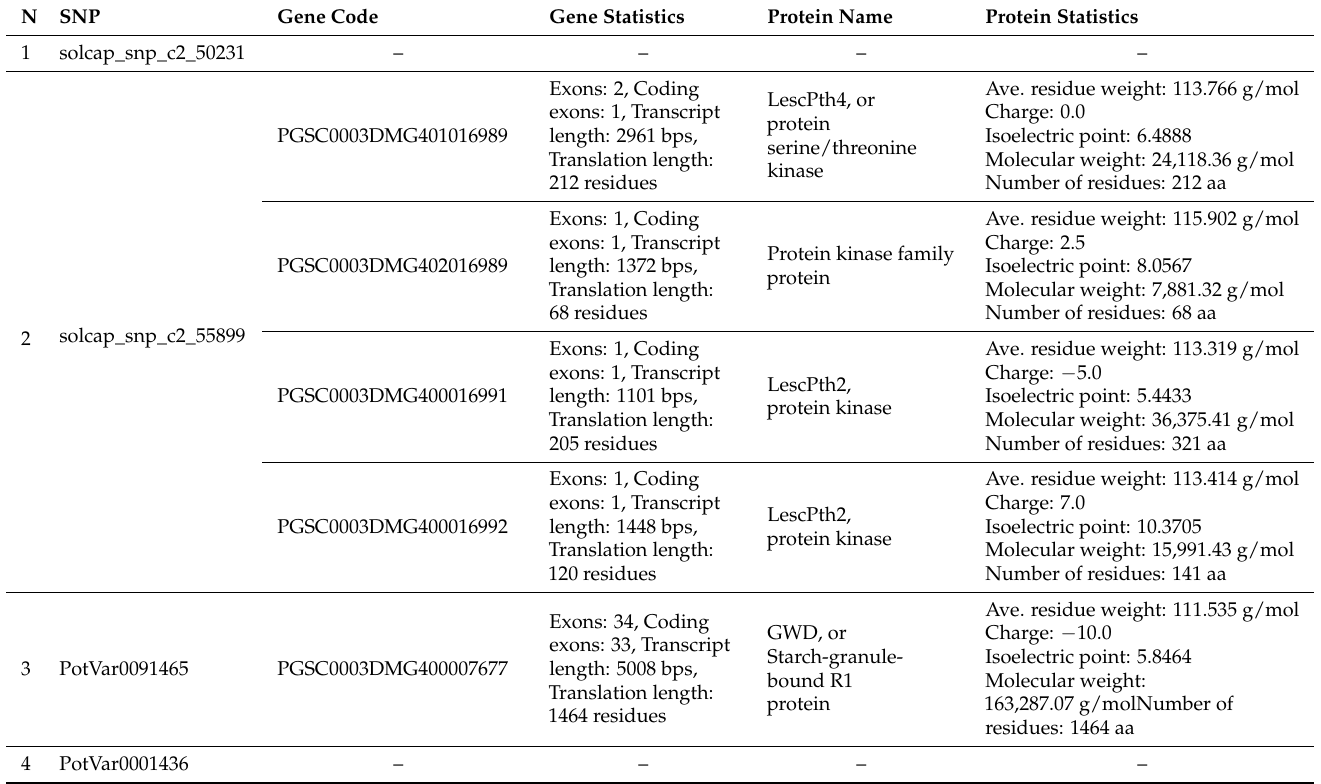
Table 6. Description of genes and their products (according to Plant.Essemble.com), associated with the protein-coding SNPand QTLs identified in the current